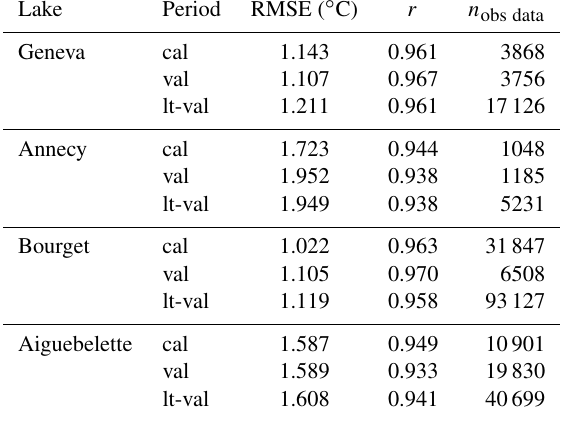
Table 6. MyLake performance indicators of water temperature simulations (root mean square error, RMSE, and Pearson correla- tion coefficient, r ) for the calibration and validation periods (val: 10 years, lt-val: long term); n obs data : number of limnological ob- servation data for comparison with simulated